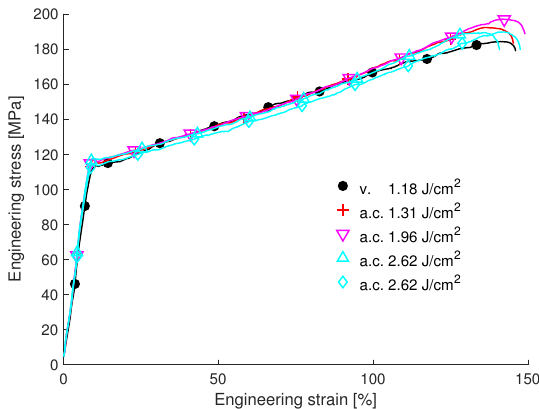
Figure A2. Influence of the ambient processing conditions on the tensile experiments of PET foils in MD. For atmospheric conditions (a.c.) and fluence value of 1.31 and 1.96 J/cm 2 one sample was tested. For the fluence of 2.62 J/cm 2 two curves are given. Comparing samples processed with increasing fluence under a.c. with samples processed under vacuum conditions (v.) does not reveal any influence. The scatter of the data lies within the scatter observed in